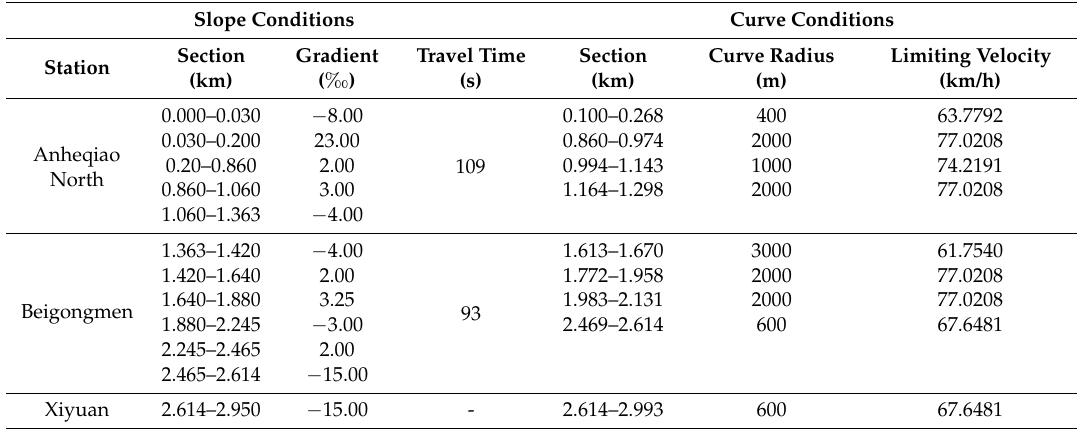
Table 1. The line conditions.